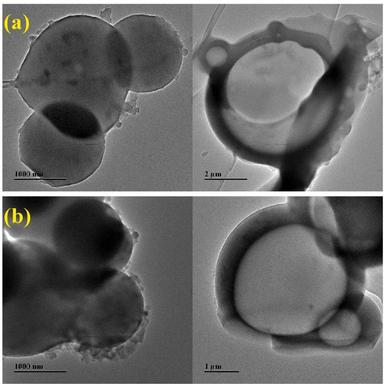
TEM images of (a) MicroEPCM-4%BN; (b) MicroEPCM-6%SiC.